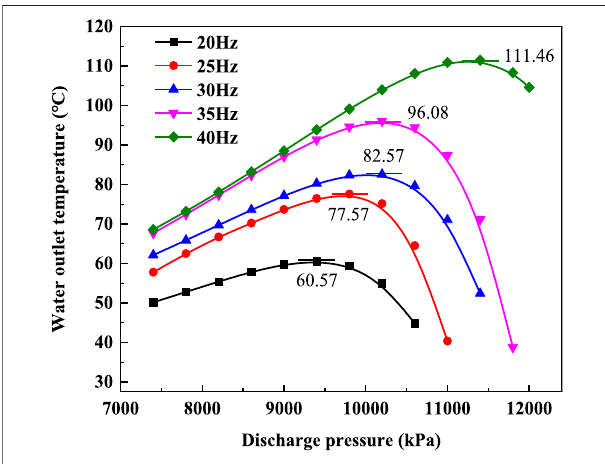
FIGURE 14 | Changes of GCW with discharge pressure at different compressor frequencies and ambient temperature of 20 ° C.